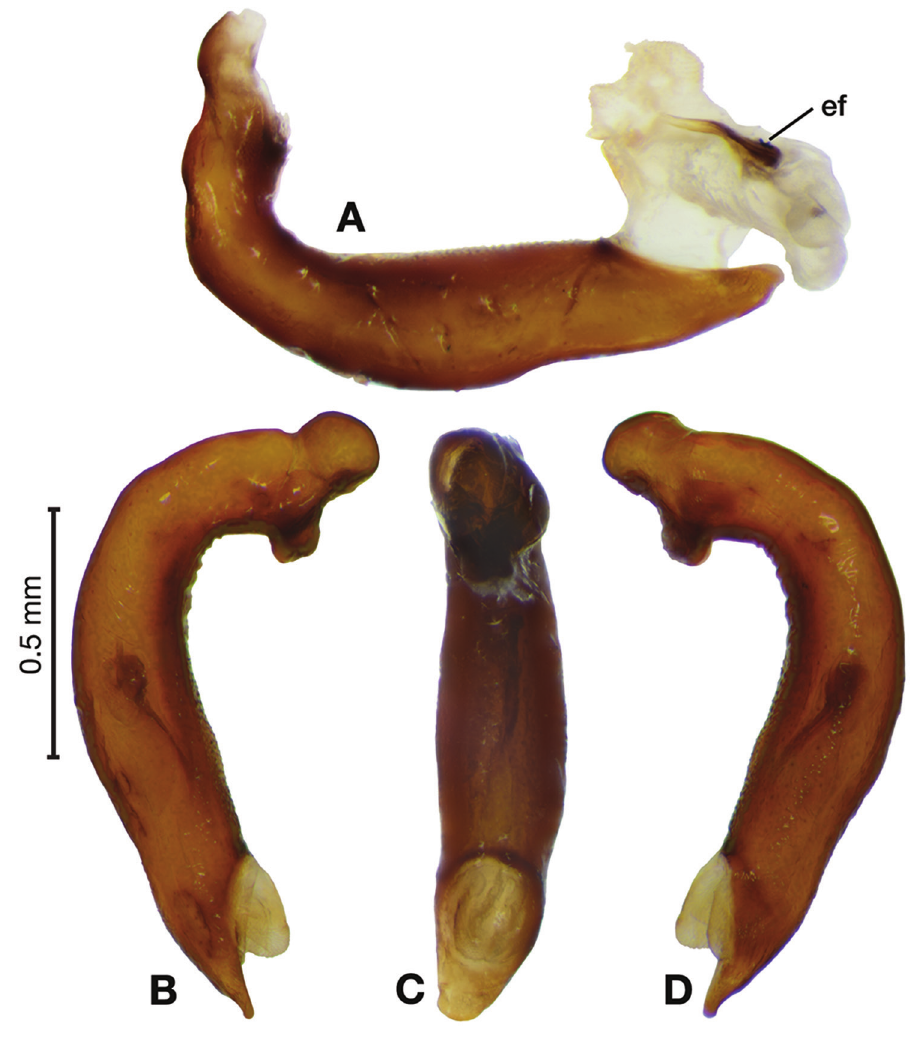
Figure 80. Digital images of male genitalia of Holcoderus formosanus Jedlička. A right lateral aspect, en- dophallus everted B right lateral aspect C ventral aspect D left lateral aspect. Legend: ef endophallic flagellum.